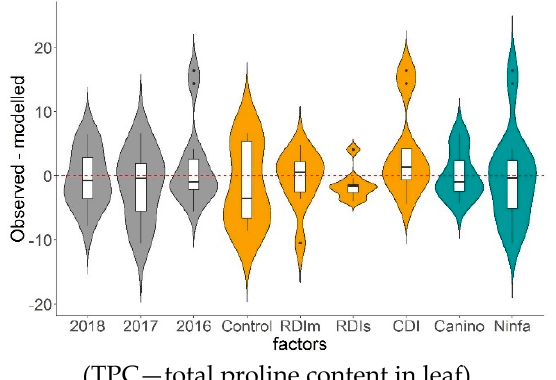
Figure 8. Distribution of the differences between the observed (boxplot) and modelled (violin plot) values by the three years (2016, 2017, and 2018; grey), four deficit irrigation treatments (Control, RDIm, RDIs, and CDI; yellow) and cultivars two cultivars (‘Ninfa’ and ‘Canino’; blue) for fifteen tree physiological (CR, HR, DEDFH, sGDD, TNB, NFB, NVB, SDF, NOFB, FBA, FS, SVG, FNT, FY, and FW) and two chemical measures (TSC, and TPC). The modelled values were prepared by GLMs (Generalized Linear Models). Explanations for Control, RDIm, RDIs, and CDI are given in Figure 2.